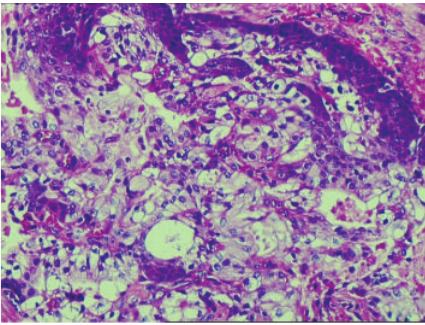
Figure 3: Histopathology showing mucous secreting cells and inter- mediate